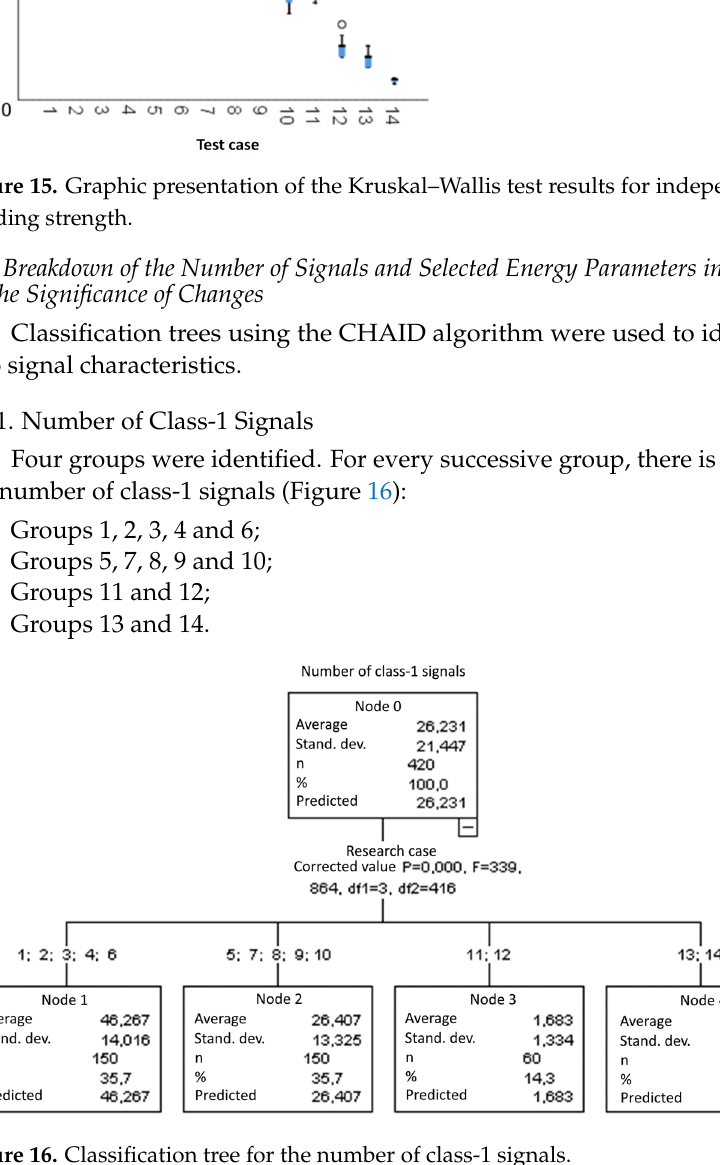
Figure 16. Classification tree for the number of class-1 signals.